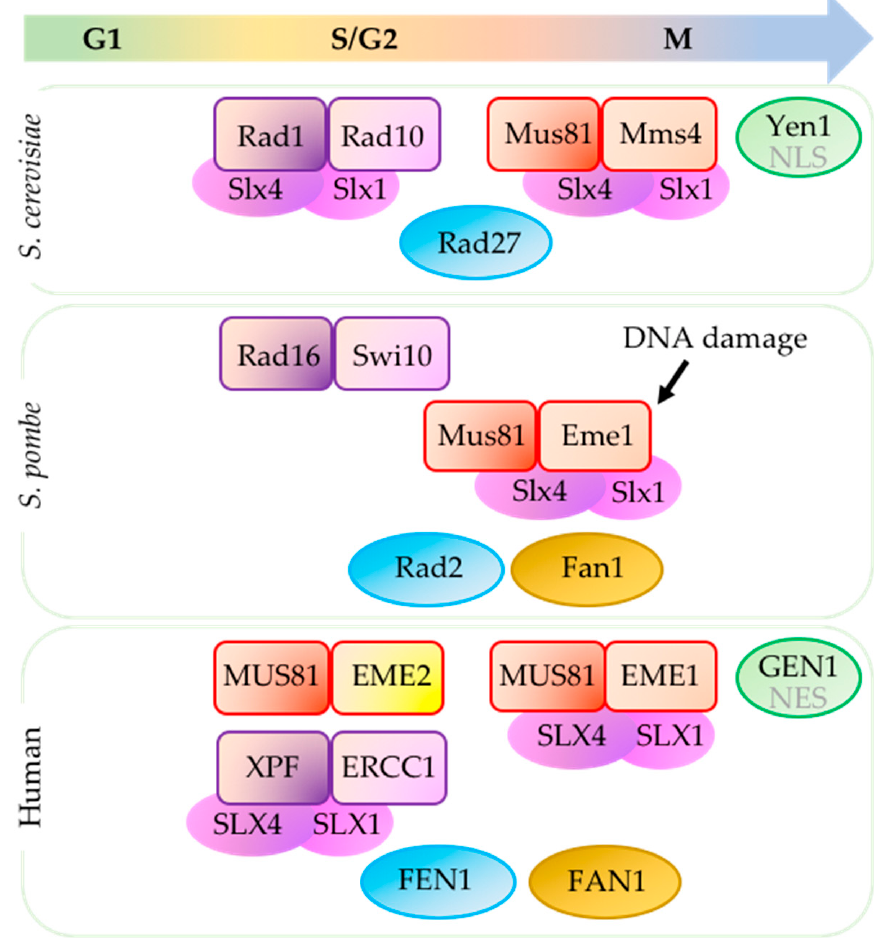
Figure 1. Structure-specific endonucleases (SSEs) in different phases of the cell cycle. Mus81 (methyl methane sulfonate (MMS) and UV-sensitive protein 81) activity in Saccharomyces cerevisiae and human cells is stimulated during G2-M transition (reviewed in [8]). In Schizosaccharomyces pombe, Mus81 is activated by DNA damage. Xeroderma pigmentosum group F complementing protein (XPF)-excision repair cross-complementing group 1 (ERCC1) (orthologs Rad1-Rad10 S.c. and Rad16-Swi10 S.p. ) is important for various DNA repair pathways and cleaves replication intermediates during S and G2 phases [10]. Scaffold protein SLX4 with associating partner SLX1 interacts with MUS81-EME1